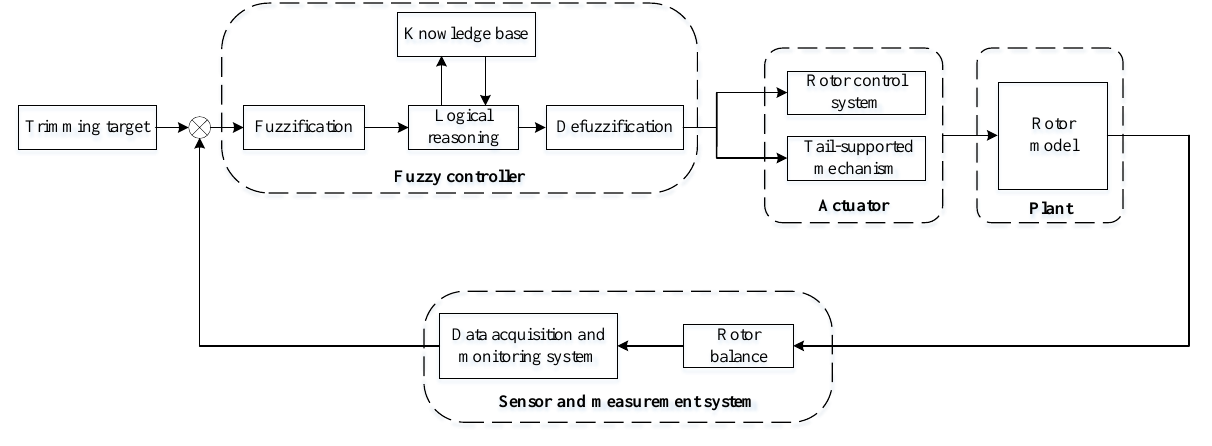
Figure 2. The structure diagram of the fuzzy-control automatic trimming system.